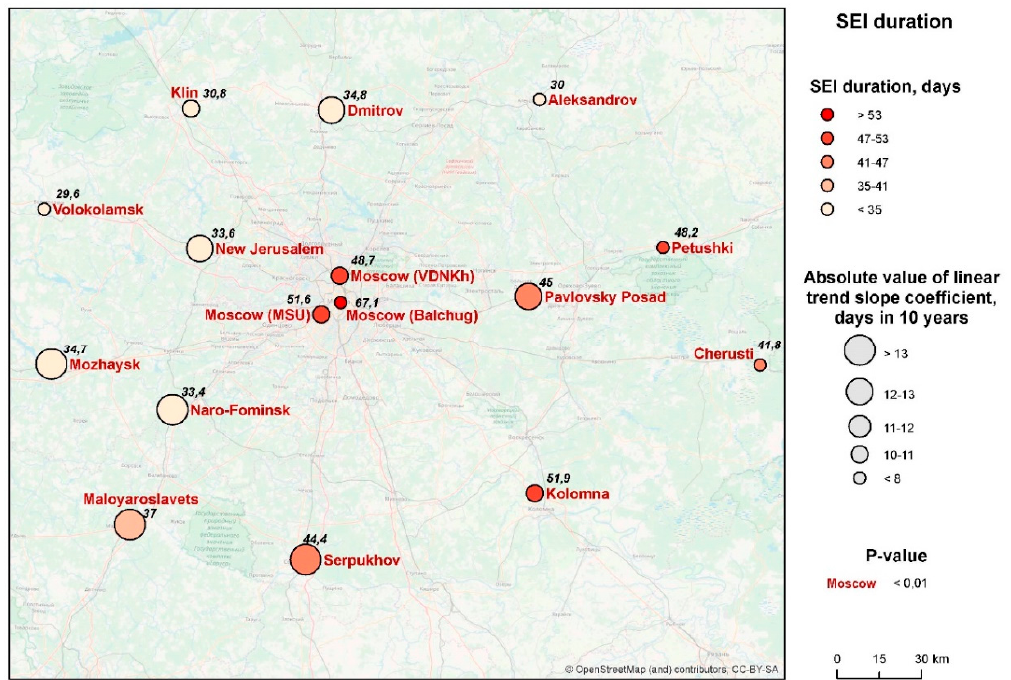
Figure 8. Spatial distribution of changes in the duration of the SEI in the Moscow region (the numbers for each station indicate the average duration of the SEI for the period).